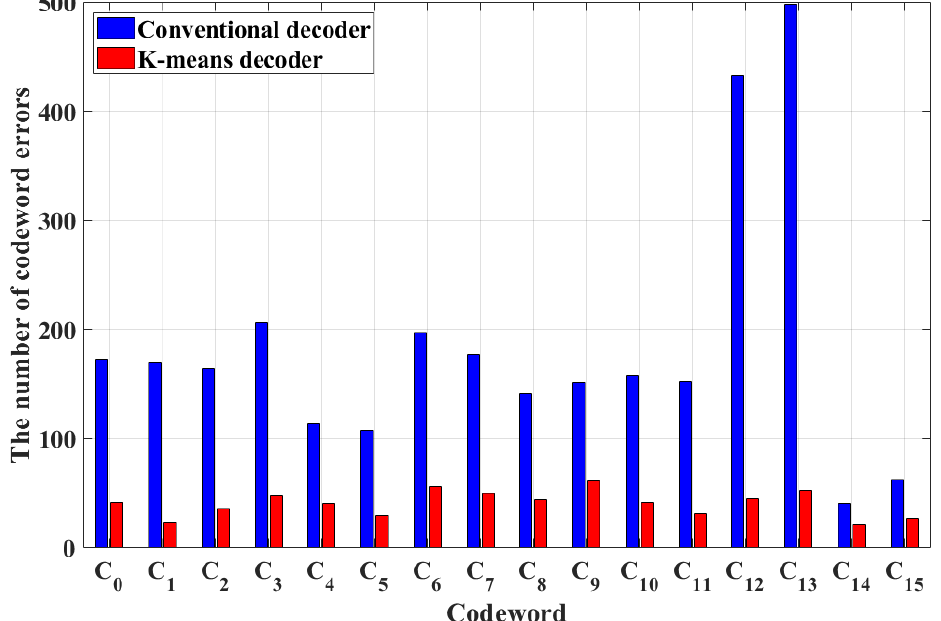
Figure 6. The number of codeword errors depending on modulation decoding schemes when the SNR is 10 dB.